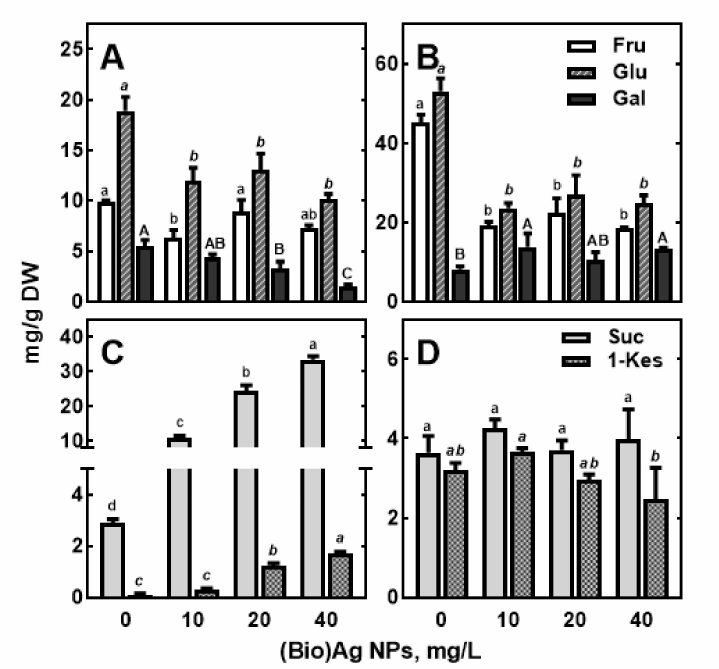
Figure 8. The effect of (Bio)Ag NPs on fructose (Fru), glucose (Glu), galactose (Gal), sucrose (Suc), and 1-kestose (1-Kes) contents in roots ( A , C ) and coleoptile ( B , D ) of 3-days-old seedling of wheat ( Triticum aestivum L. cv. ‘Ostka Strzelecka’). Values are means ( n = 3) ± SD. Bars marked with the same letters are not significantly ( p < 0.05) different when calculated with ANOVA and Tukey’s post hoc